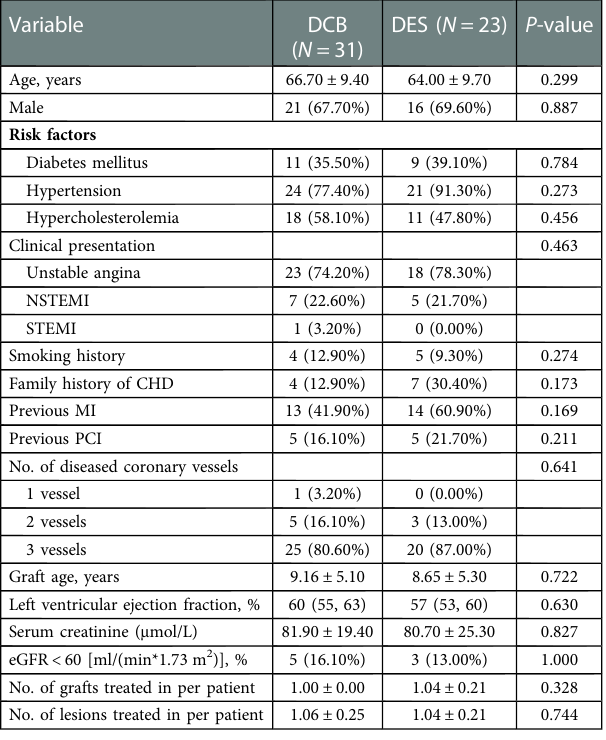
TABLE 1 Baseline clinical characteristics. TABLE 2 Baseline lesion and procedural